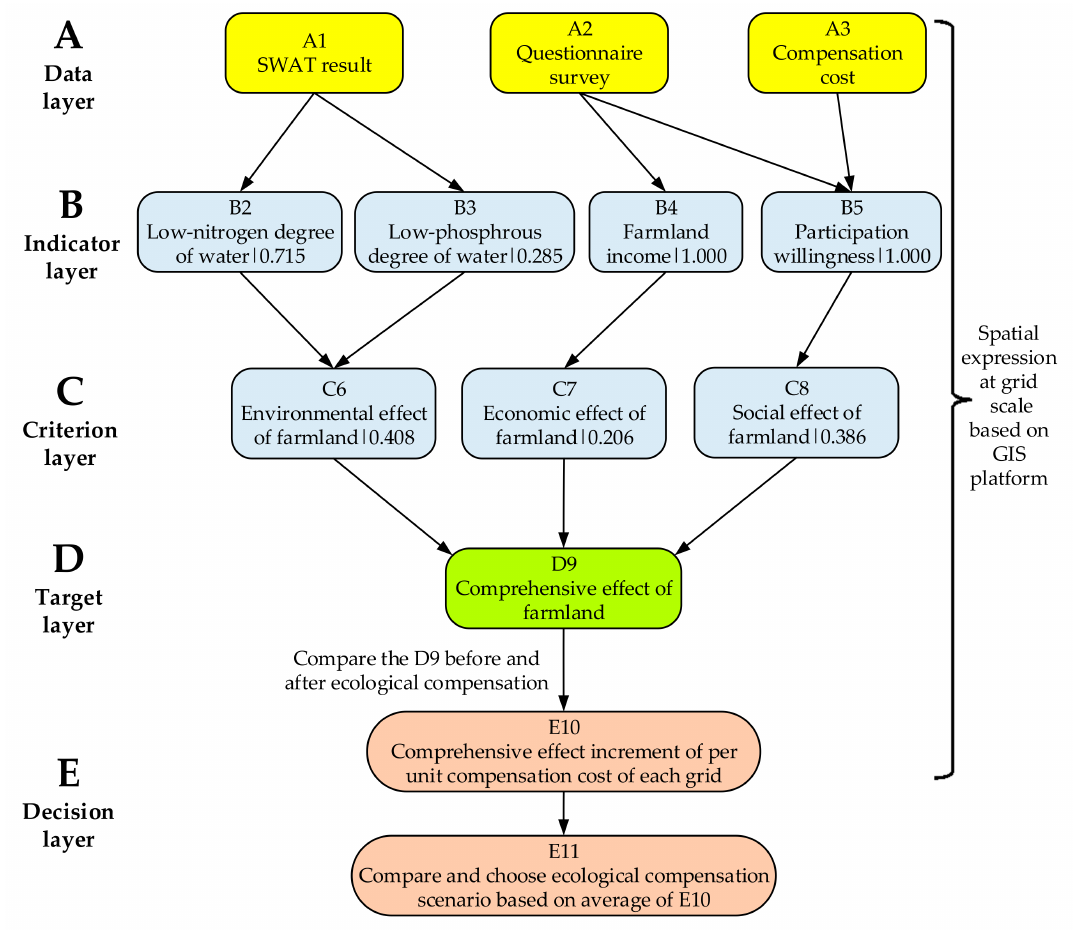
Figure 5. Hierarchy structure of comprehensive evaluation model (where the number after “|” is weight).